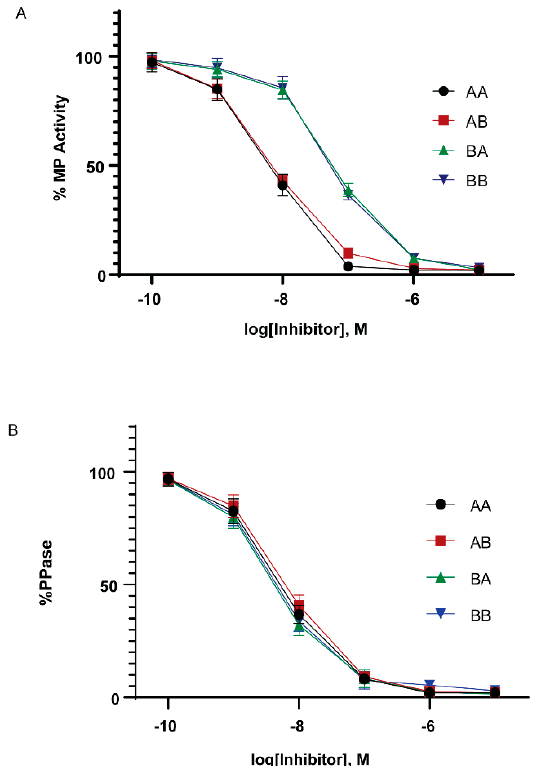
Figure 6. In vitro inhibition of myosin phosphatase by Cpi-17 and Phi-1 paralogs. ( A ) The myosin phosphatase holoenzyme was isolated from HEK cells and used to dephosphorylate recombinant Mlc2. Increasing concentrations of thiophosphorylated ppp1r14aa (AA, circle), ppp1r14ab (AB, red square), ppp1r14ba (BA, green triangle), or ppp1r14bb (BB, blue triangle) proteins were added, and the extent of Mlc2 dephosphorylation is reported as percent phosphatase activity. ( B ) Isolated PP1catalytic subunit was used to dephosphorylate Mlc2. Increasing concentrations of thiophosphorylated ppp1r14aa (AA, circle), ppp1r14ab (AB, red square), ppp1r14ba (BA, green triangle), or ppp1r14bb (BB, blue triangle) proteins were added, and the extent of Mlc2 dephosphorylation is reported as percent phosphatase activity. Each experiment was repeated three times in duplicate, and error bars indicate standard error.